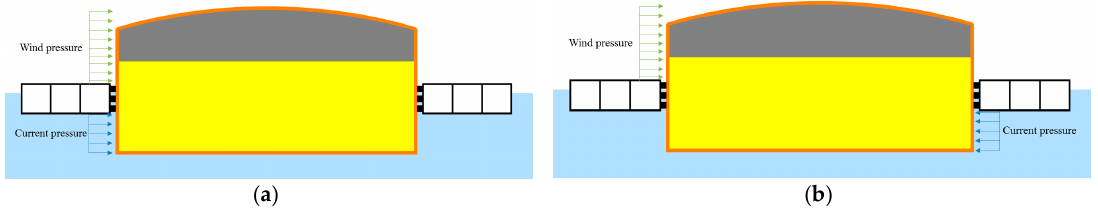
Figure 12. Tank subject to wind and current forces acting in the ( a ) same and ( b ) opposite directions.